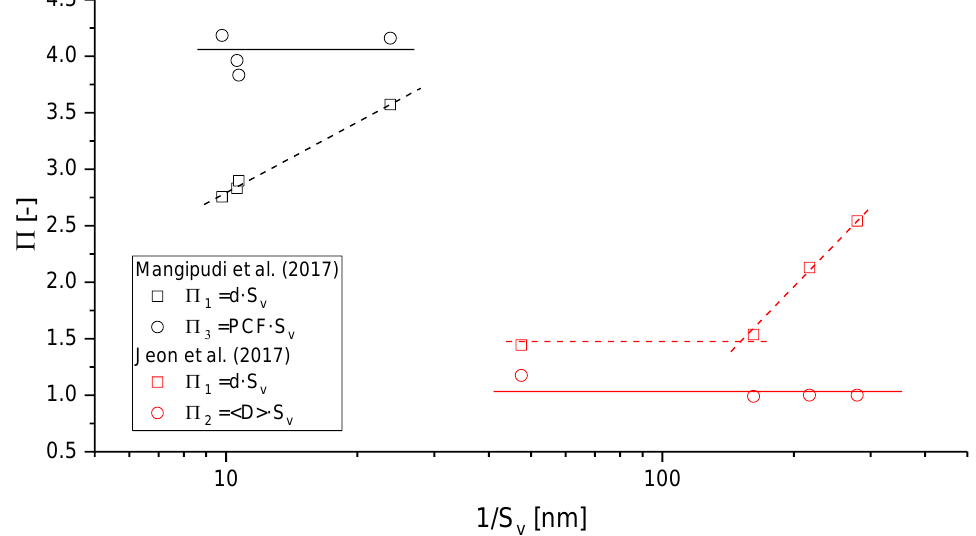
Figure 9. Dimensionless parameters derived from various characteristic lengths provided in the literature and their reliability in the assessment of self-similarity. Data has been taken from [43,88].